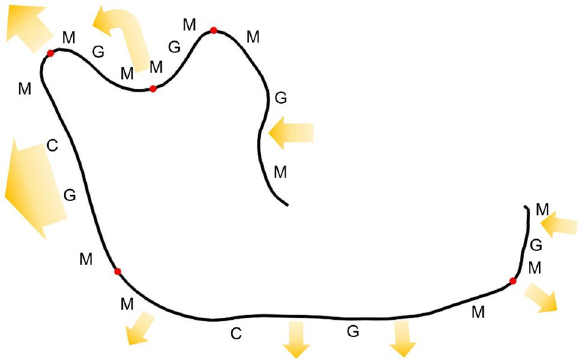
Figure 6. A profile ( j = 1 ) from the H. erectus group: Five apices (red circle) are located using the relative angle method ( k = 150 , T = 20 ◦ ) and divide the profile into six sub-profiles. The arrows represent the growth pattern of the mandible 28